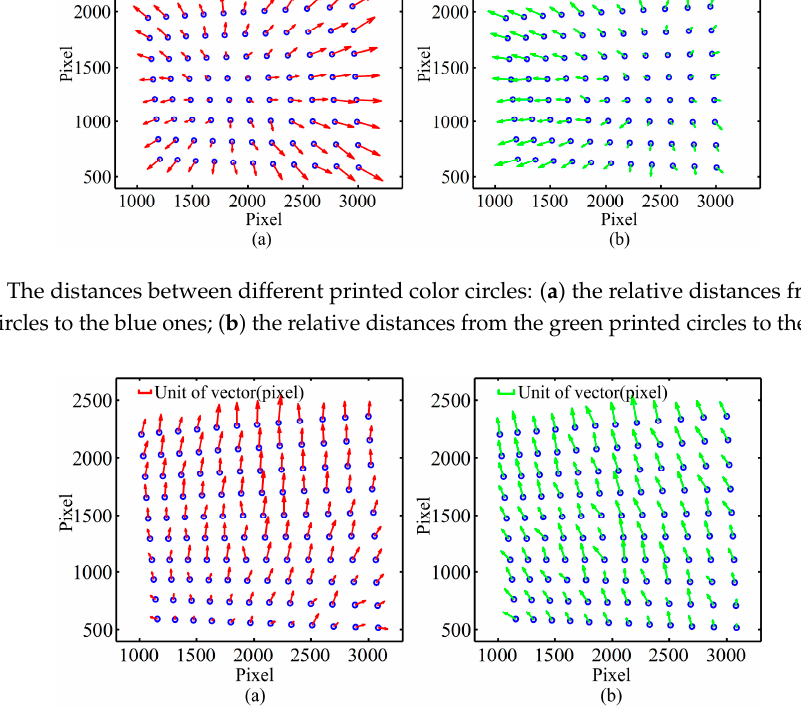
Figure 4. The distances between different projection color circles: ( a ) the relative distances from the red projection circles to the blue ones; ( b ) the relative distances from the green projection circles to the blue ones.